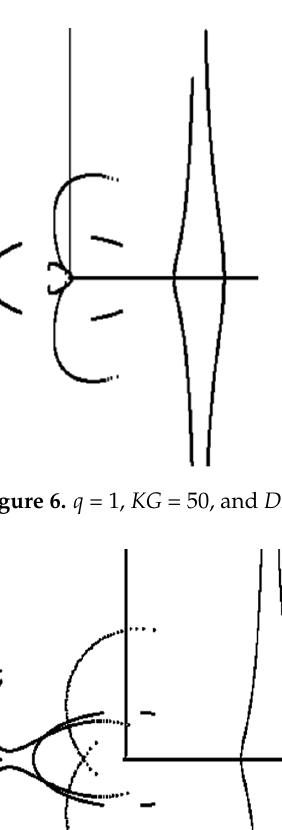
Figure 5. q = 1, KG = 100, and DK = 140.